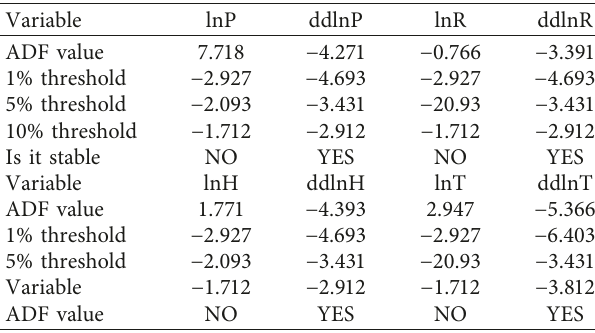
Table 1: ADF unit root test results of model variables.